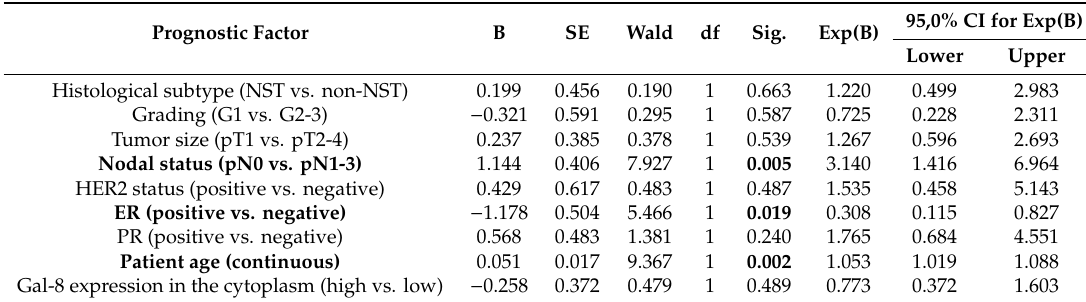
Table 5. Cox regression analysis of prognostic factors for OS in breast cancer patients. Significant factors are highlighted in bold.